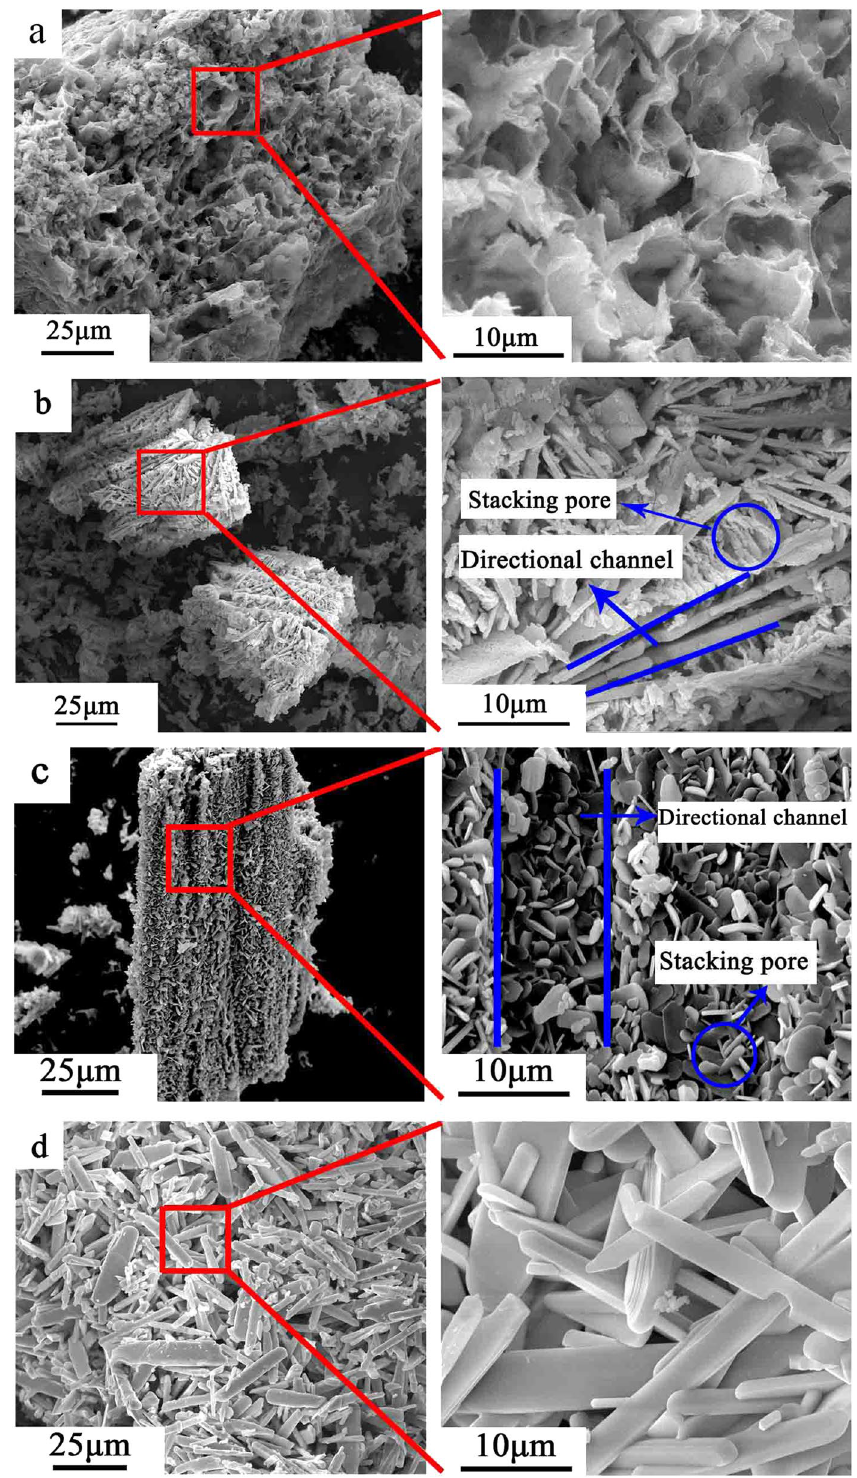
Figure 2. SEM images of MoO 3 synthesized at different sintering temperature: ( a ) 300 °C, ( b ) 400 °C, ( c ) 500 °C, ( d ) 600